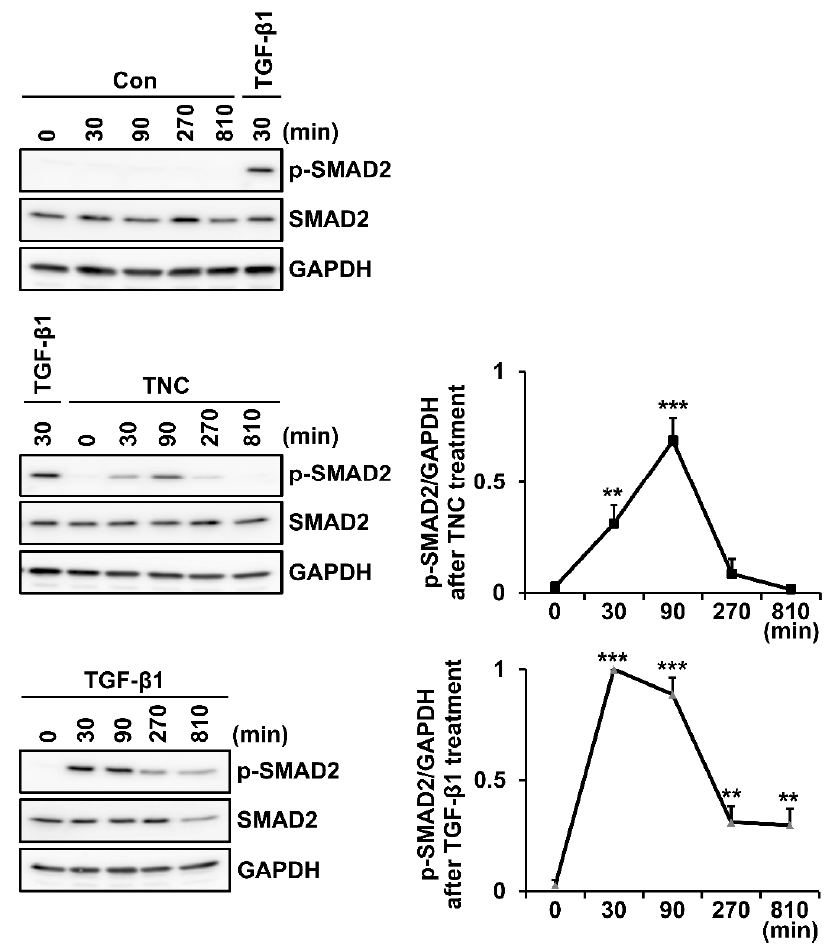
Figure 5. Time course effect of TNC on SMAD2 phosphorylation in fibroblasts. Serum-starved human foreskin fibroblasts were treated with vehicle (Con), TNC (2 µg/mL), or TGF- β 1 (3 ng/mL). After incubation for the indicated durations (0, 30, 90, 270, and 810 min), cell lysates were analyzed by western blotting using antibodies against phospho-SMAD2 (p-SAMD2), SMAD2, and GAPDH. Relative intensity of p-SMAD2/GAPDH in samples treated with TNC or TGF- β 1, normalized to a sample treated with TGF- β 1 for 30 min, are shown in graphs. Each value represents the mean ± SD of four independent experiments. ** p < 0.01, *** p < 0.001 vs. 0 min.